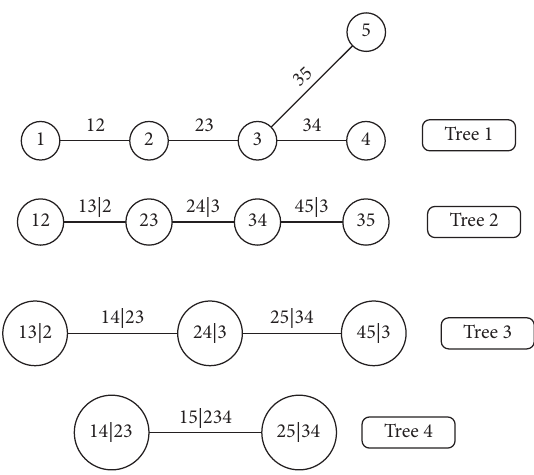
Figure 1: 5-dimensional R-vine copula, 4 trees and 10